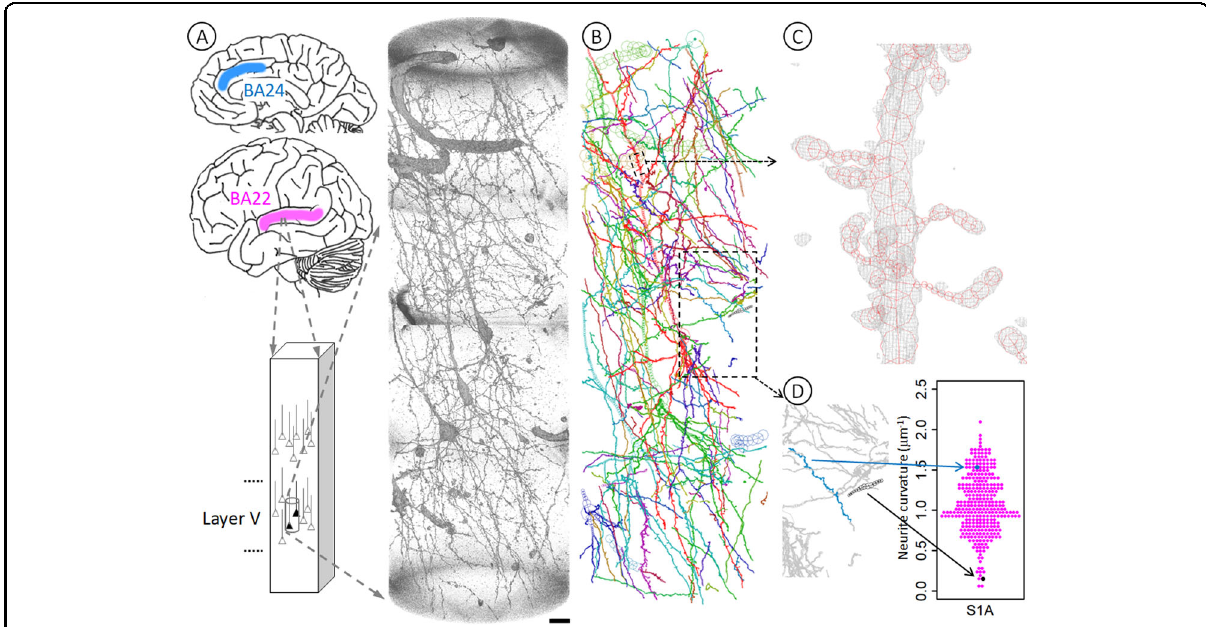
Fig. 1 Geometric analysis of neurons at nanometer scale. A Brain tissues of Brodmann area 22 (BA22, magenta) of the temporal lobe were stained with Golgi impregnation and subjected to synchrotron radiation nanotomography to visualize three-dimensional tissue structures in layer V. The obtained datasets along with those of the BA24 area (blue) of the anterior cingulate cortex were used for the geometric analysis. The rendering shows a three-dimensional image of the S1A dataset taken from BA22 tissue of the schizophrenia S1 case. The pial surface is toward the top. Voxel values of 160 – 800 were rendered with the scatter HQ algorithm using VGStudio (Volume Graphics, Germany). Scale bar: 10 μ m. B The neuronal network was reconstructed in Cartesian coordinate space by tracing structures in the image. First, neurites were scanned by calculating the gradient vector fl ow 37 and then traced using a three-dimensional Sobel fi lter 38 . The resultant computer-generated model was examined and edited as reported previously 9 . The obtained model of the S1A dataset was drawn using MCTrace 22 . Structural constituents are color-coded. The same analysis was repeated for 34 datasets of 4 schizophrenia and 4 control cases. C Three-dimensional cage representation of the observed image (gray) is superposed on the structural model of an apical dendrite (red) indicated with a small dashed box in B . The three-dimensional map is contoured at 3.0 times the standard deviation (3.0 σ ) of the voxel values with a grid size of 97.6 nm. Nodes composing the structure are indicated with octagons. D Three-dimensional Cartesian coordinates of the traced structure were used to calculate geometric parameters, including average curvature and average torsion for each neurite. A volume indicated with the lower box in B is magni fi ed and its two representative neurites are highlighted, of which the blue one is tortuous and hence has a high average curvature, while the black one is rather straight and hence has a low average curvature. Arrows indicate corresponding positions in the beeswarm plot that shows the curvature distribution of all neurites in this S1A